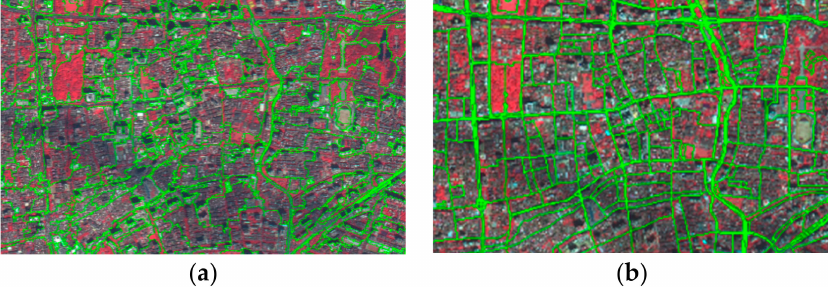
Figure 3. Comparison of segmentation results. ( a ) Results without Open Street Map (OSM) road data; ( b ) results with OSM road